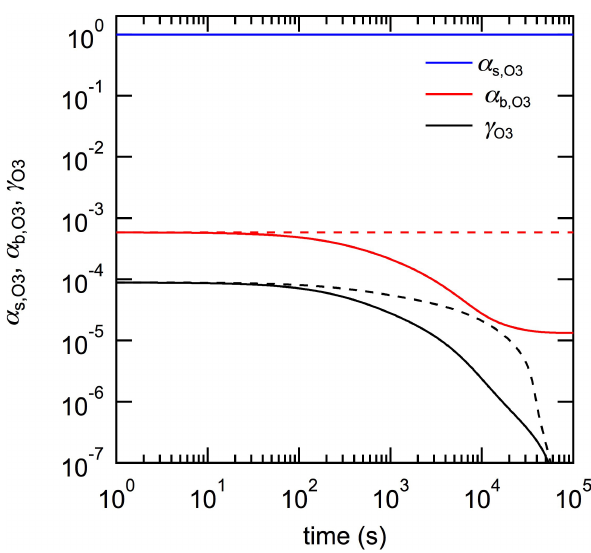
Fig. 2. Time evolution of surface and bulk accommodation as well as uptake coefficient for ozone for constant-diffusivity (dashed lines) and diffusivity-evolution (solid lines) model